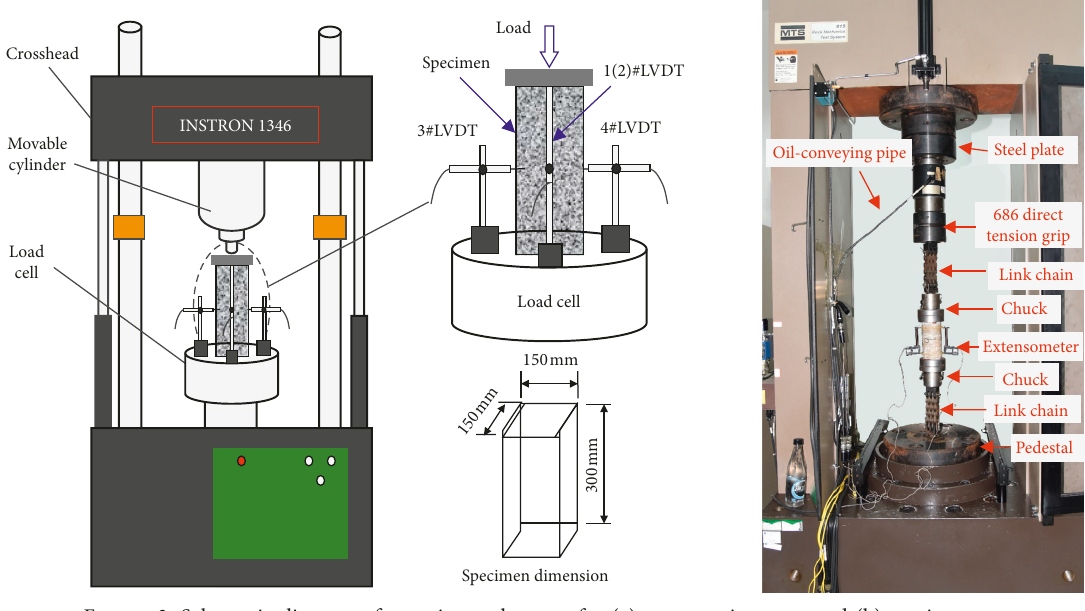
Figure 2: Schematic diagram of experimental setups for (a) compression tests and (b) tension tests.